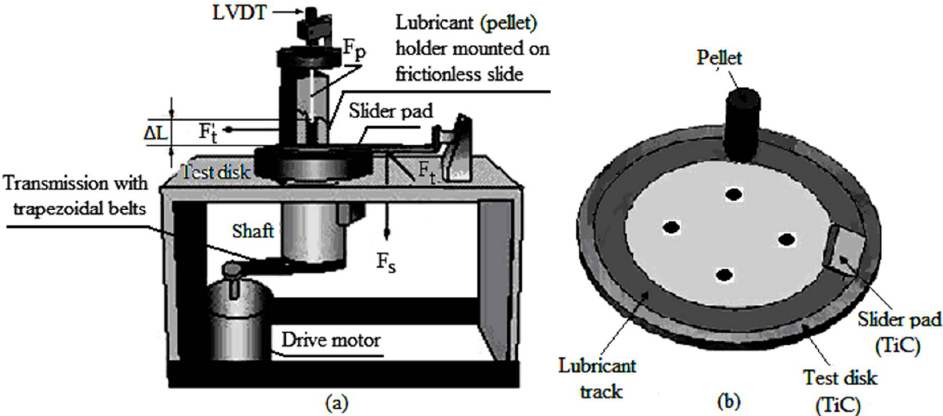
Figure 1. Experimental pellet/disk and pad/disk setup for evaluation of the friction forces pellet/disk at and slider pad/disk, and pellet wear ( a ) and schematic setup pellet/disk with slider pad/disk ( b ).